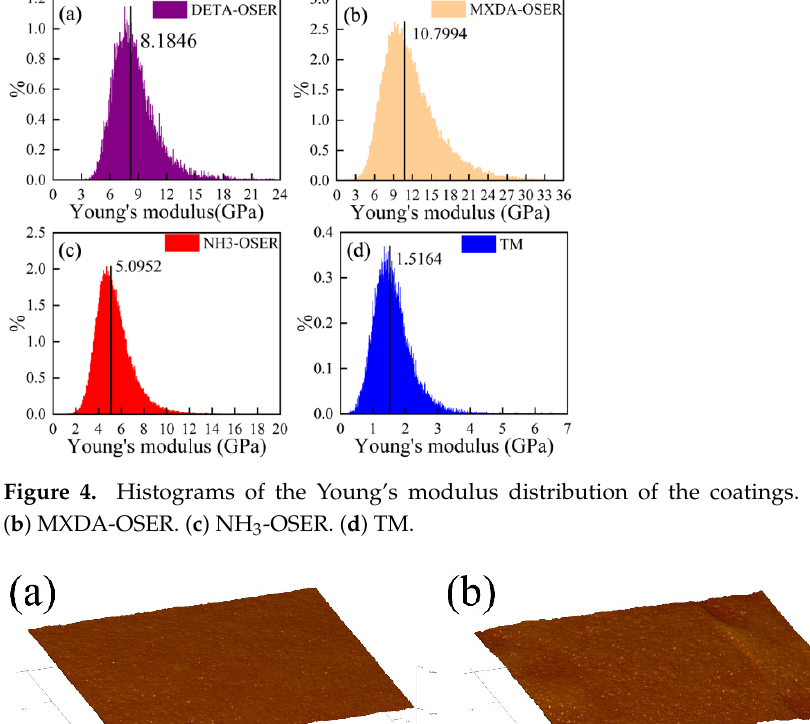
Figure 5. Spherical clusters on the surface could be observed as shown in Figure 5c,d. The roughness of NH 3 -OSER and TM (Rq = 2.024, 7.651 nm) was much higher than that of the DETA-OSER and MXDA-OSER (Rq = 0.316 nm, 0.274 nm). The result reflects that the